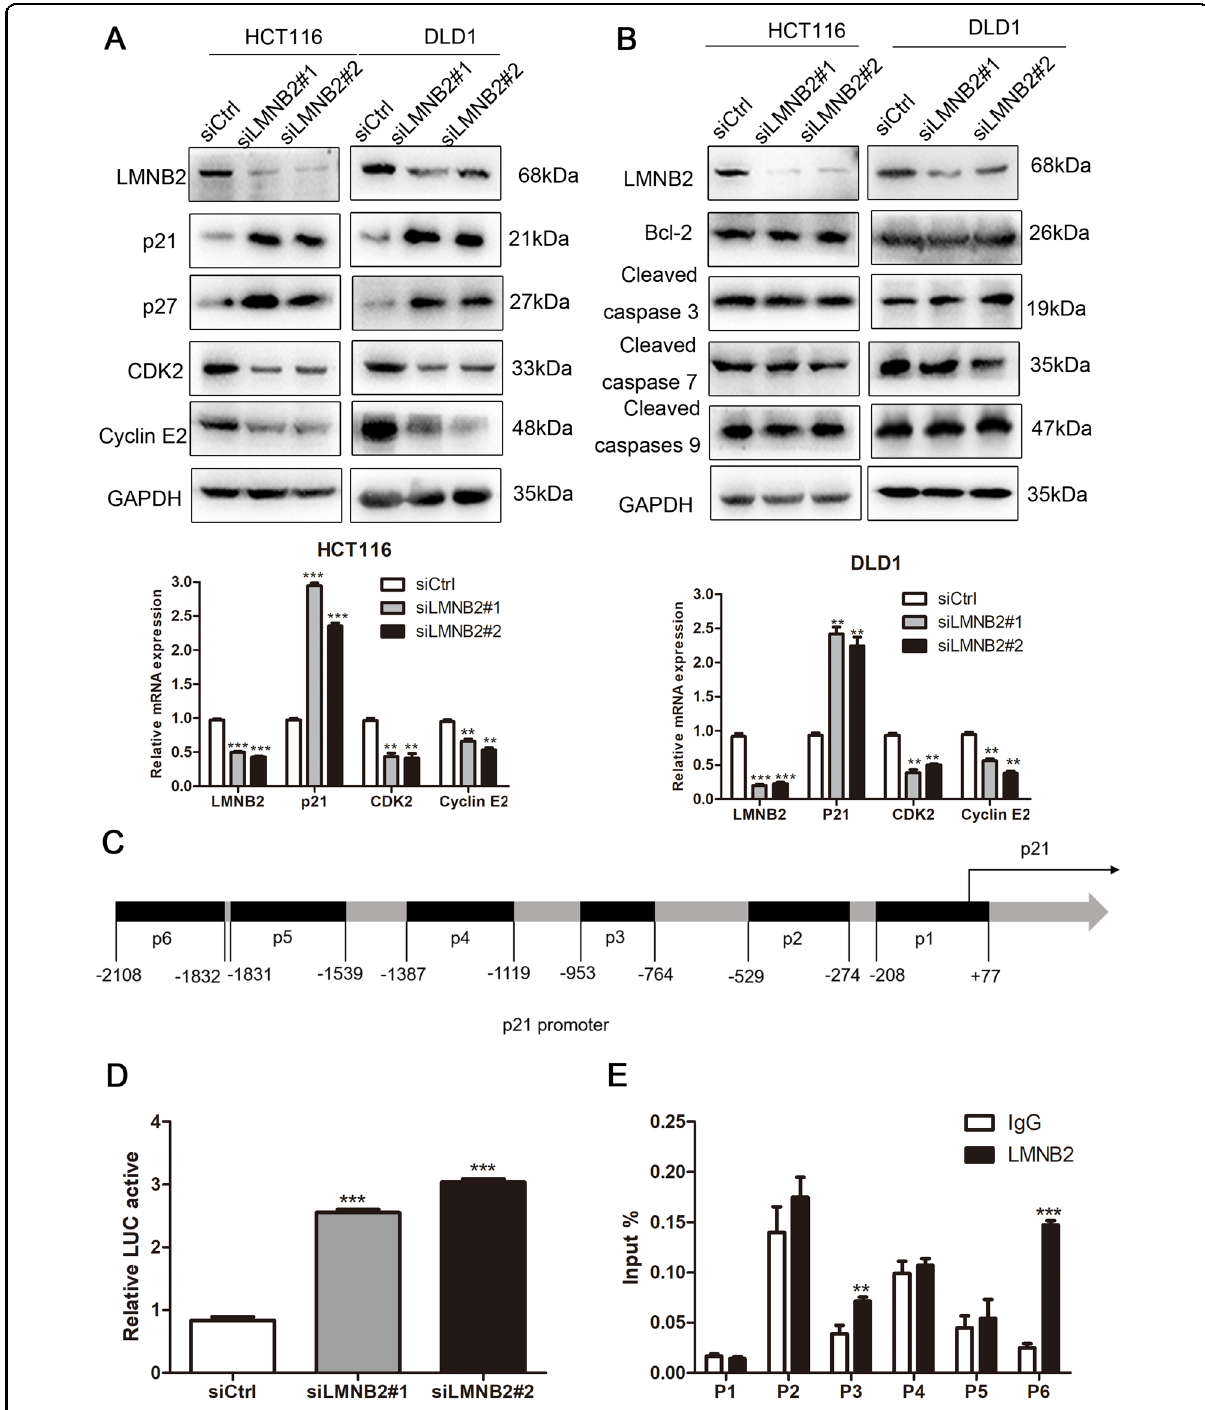
Fig. 4 LMNB2 gene knockout can induce cell cycle arrest in G0/G1 phase and inhibits the transcription of p21. A Western blotting was used to detect the expression of cell cycle and apoptosis-related genes. GAPDH was used as a reference control. B Real-time fl uorescence quantitative PCR detects the relative expression of cell cycle-related genes at the mRNA level. GAPDH was used as a reference control. C The complete sequence of the human p21 promoter. P1-6 shows the p21 promoter region detected by two pairs of primers. D The activity of p21 promoter (LMNB2 2400/11) in − 116 cells was enhanced after LMNB2 gene knockout. E Three-dimensional ChIP quantitative PCR analysis of the binding of LMNB2 at P1, P2, P3, P4, P5, and P6. Western blot detection of LMNB2 in ChIP detection. The mean ± SD of three experiments is given. * P < 0.05, ** P < 0.01, * P < 0.001.